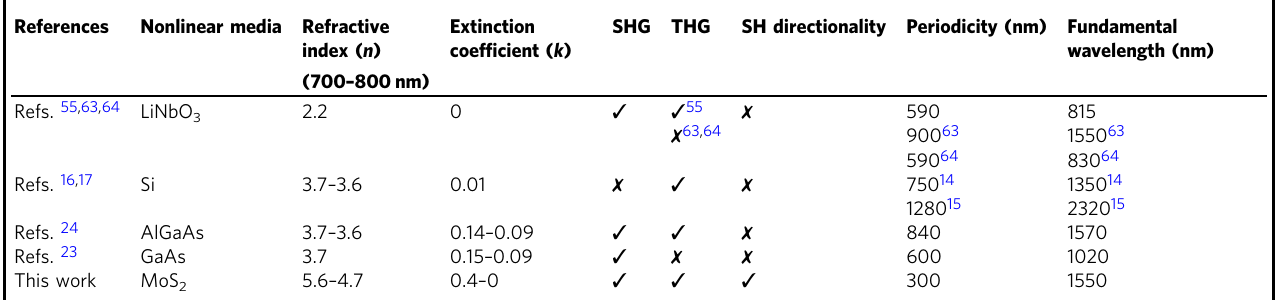
Table 1 Performance comparison of the MoS 2 metasurface with other high index dielectric